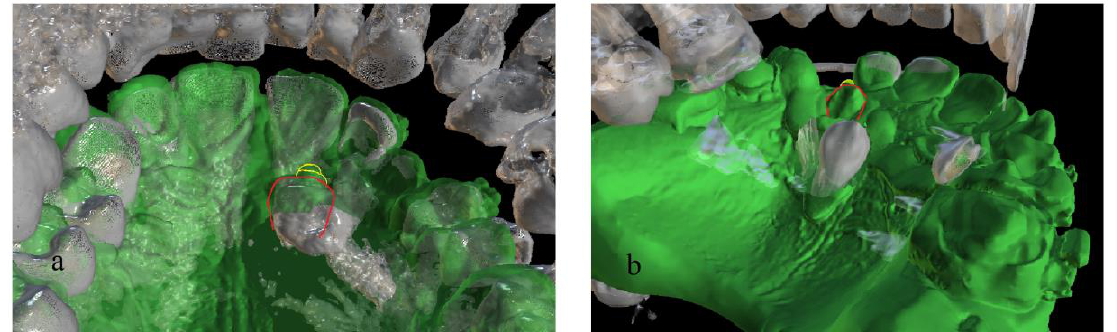
Figure 11. Superimposition of initial Cone-Beam Computed Tomography (CBCT) and stereolithogra-